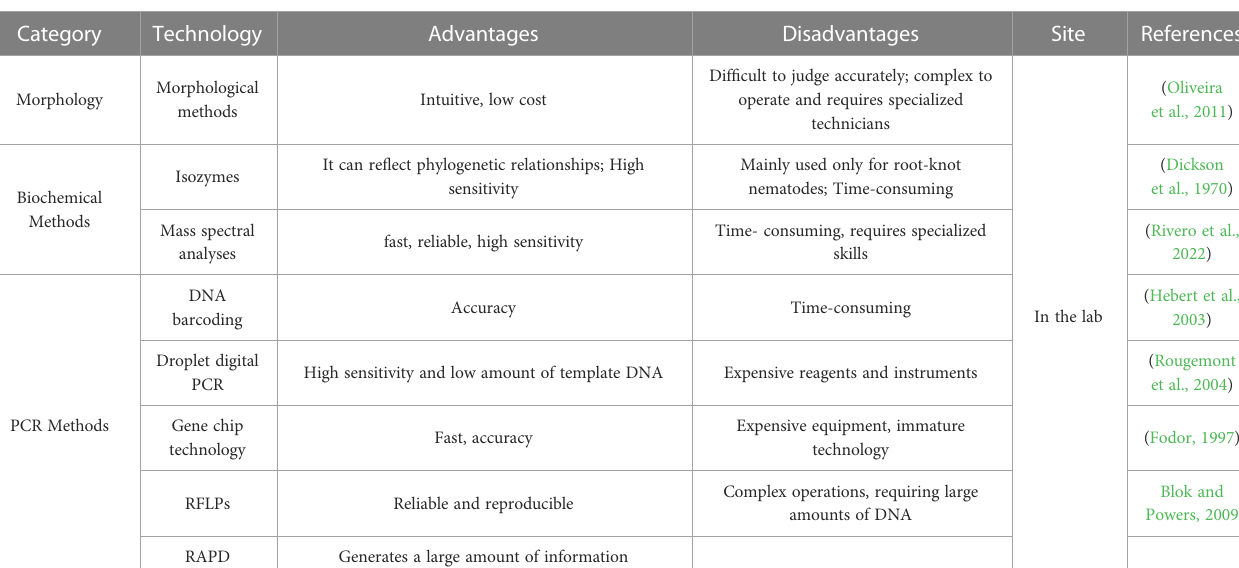
TABLE 4 Comparison of different plant nematode detection